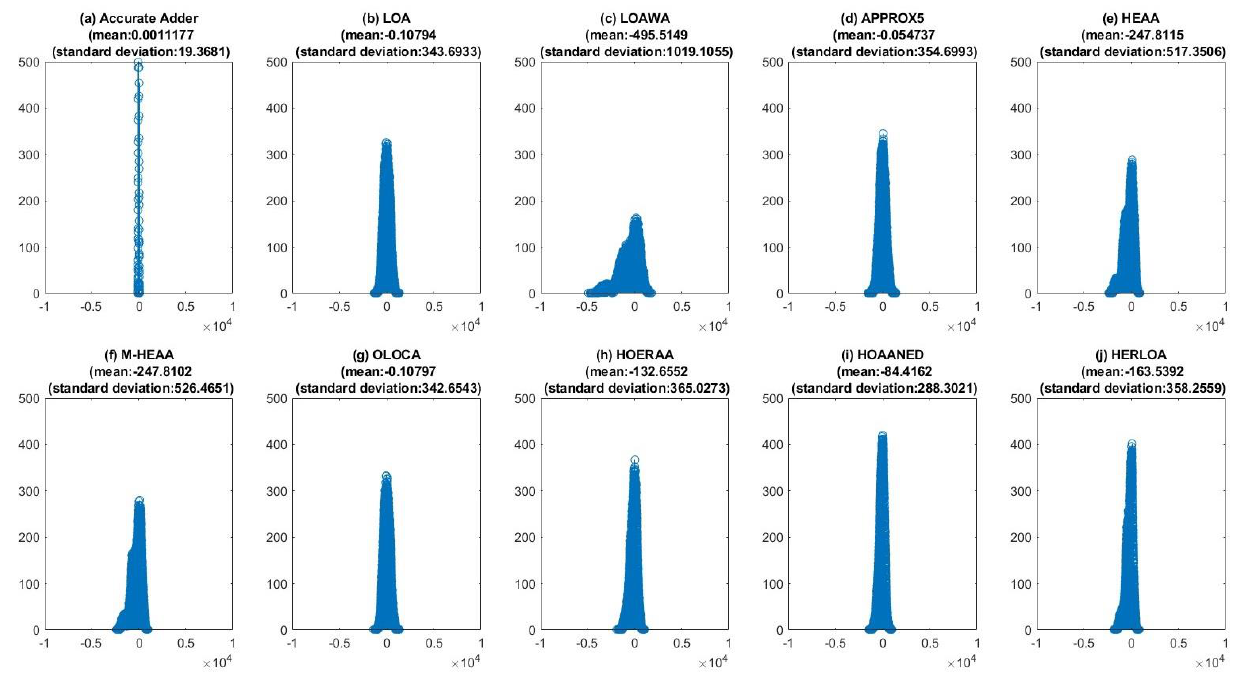
Figure 6. Plots showing the difference in pixel values (DPV) between the La Silla image compressed using accurate and approximate adders and the original La Silla image, with the approximate adders having a 10-bit inexact part.